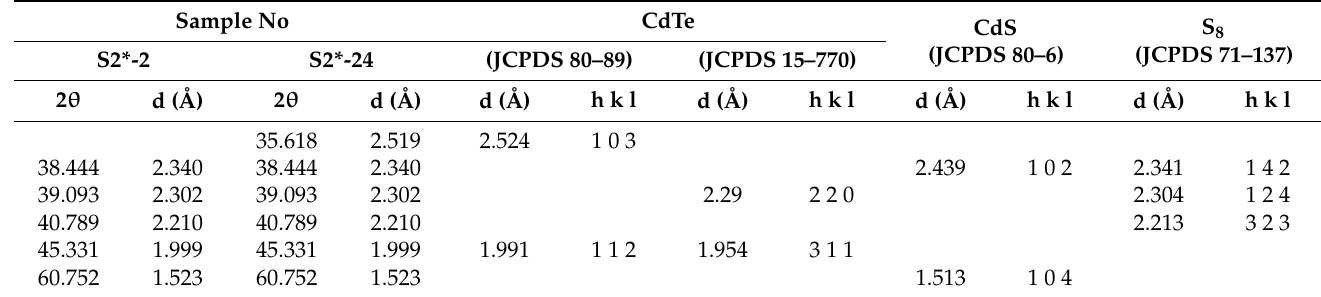
Table 6. XRD peak assignments of cadmium chalcogenide layers on PA